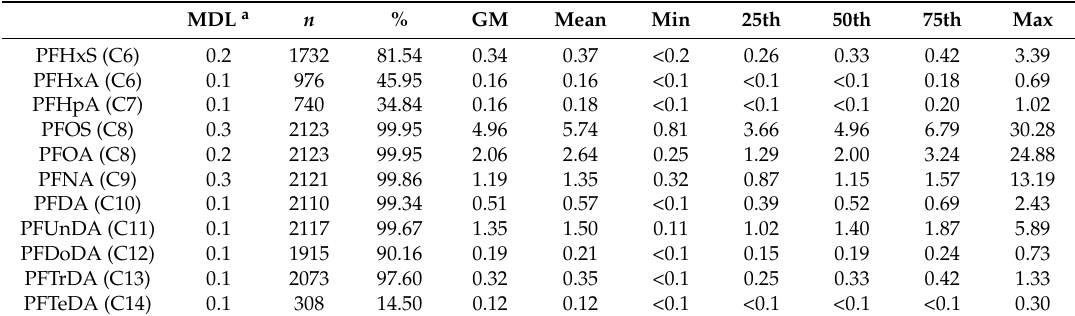
Table 2. Distribution of 11 PFAS in plasma from pregnant women.